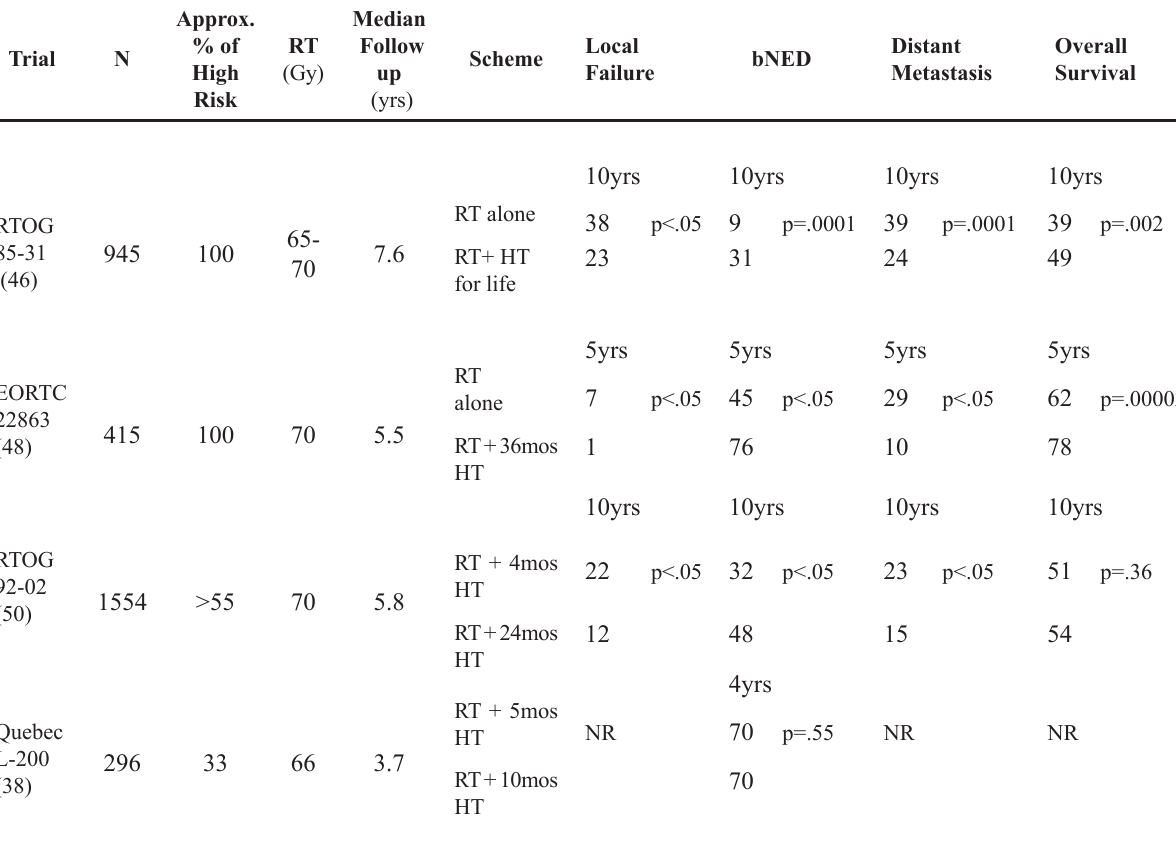
Table 2 – Completed phase III trials of adjuvant androgen deprivation